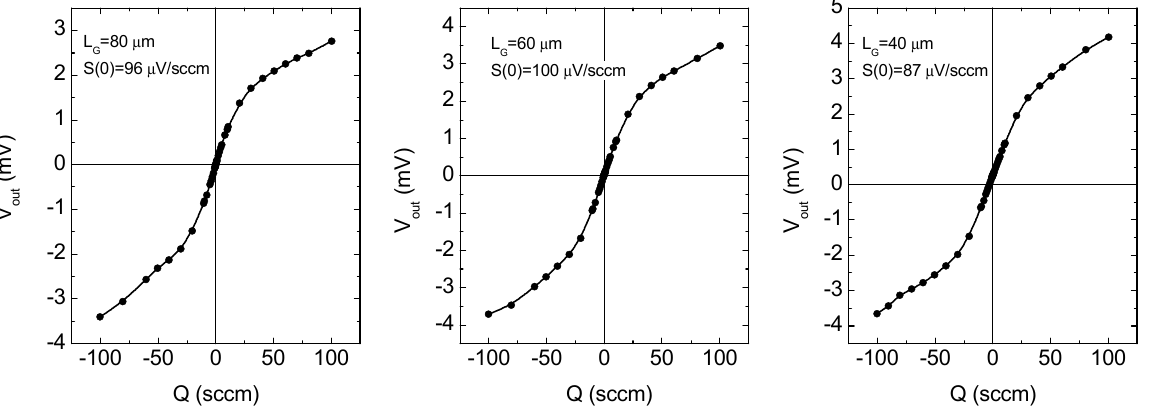
Figure 10. Response to a nitrogen flow of the three single heater structures, differing for the dimension of the thermopile-heater gap L sensitivity at zero flow.